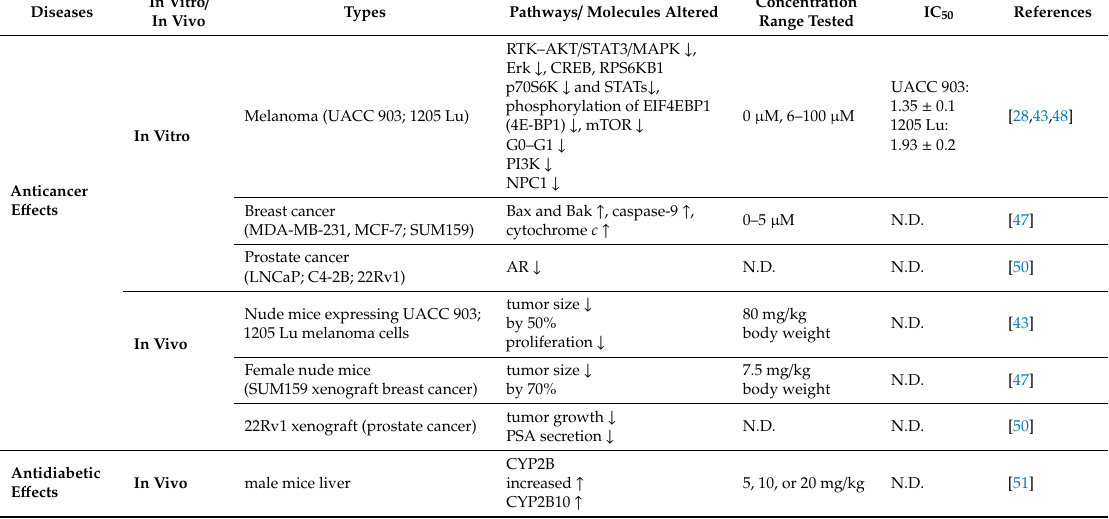
Table 1. Reported pharmacological e ff ects of